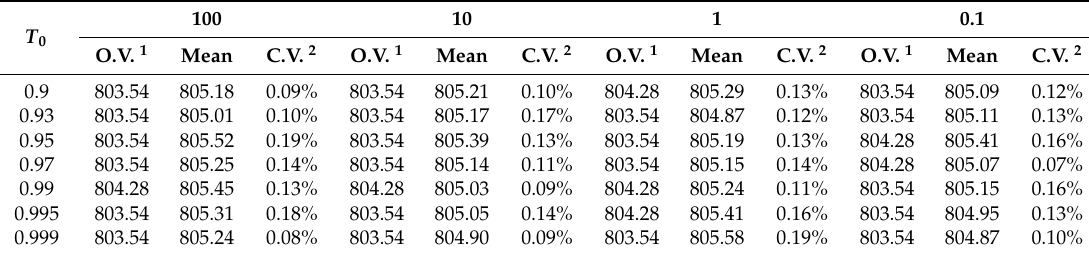
Table 6. Determination of simulated annealing parameters ( T 0 - α